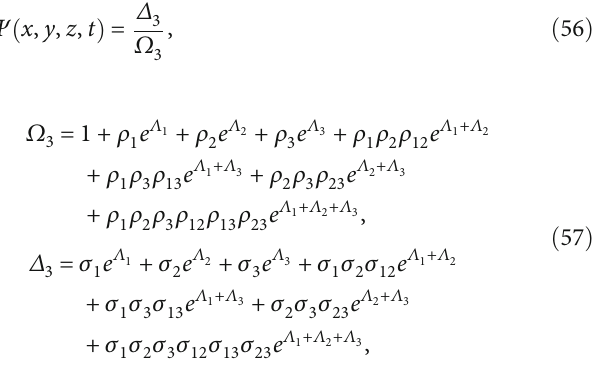
Figure 9: The three-wave solution (48) at α = 2 : 2, β δ 3